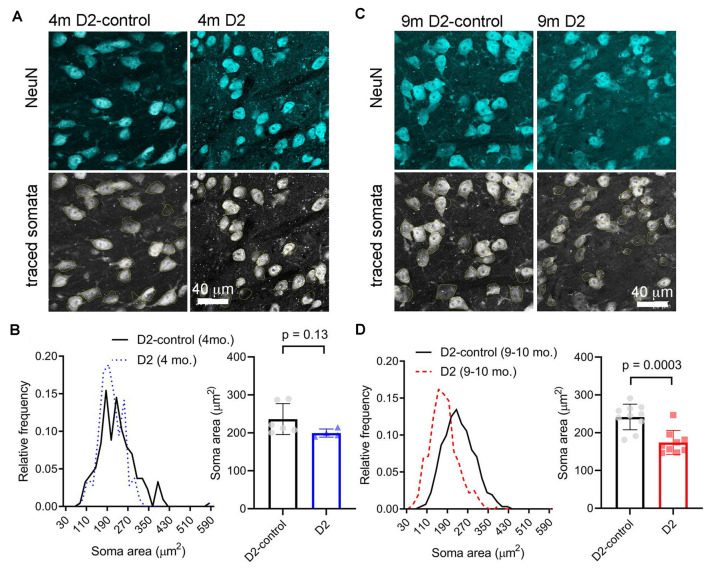
Measurement of TC neuron soma size in 4 to 9 m D2 mice. Fifty-micron dLGN sections were stained using a NeuN primary antibody to label neurons while a GAD65/67 antibody was used to identify and exclude GABAergic interneurons. (A,C) After imaging, TC neuron somata were traced. Lower panels show the somatic outlines (yellow). (B) At 4 m, TC neurons size was not significantly different between D2 mice (n = 106 cells from four mice), and D2-controls (n = 214 cells from six mice, p = 0.13, nested t-test). (D) At 9 m, TC neuron soma size was reduced in D2 mice (n = 321 cells from nine mice) compared to D2-controls (n = 312 cells from 10 mice; p = 0.0003, nested t-test).